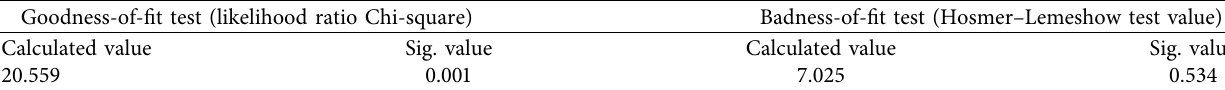
Table 7: Fitting degree